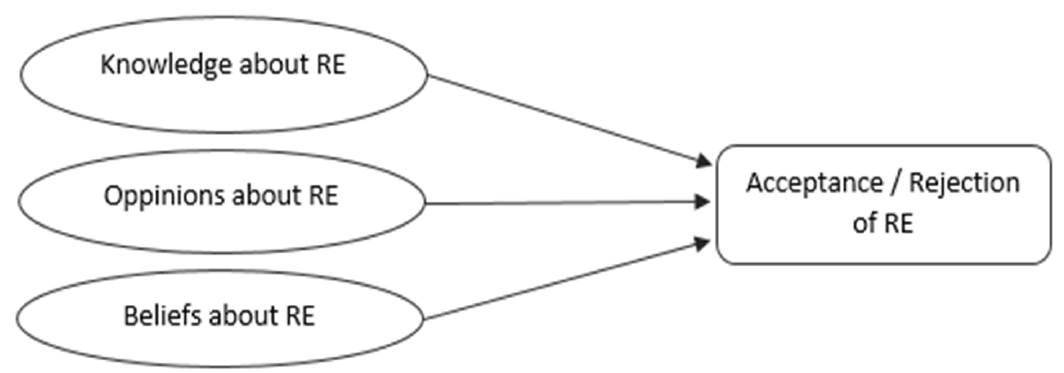
Figure 7. Main variables used to investigate rural residents’ attitudes towards RE technologies.